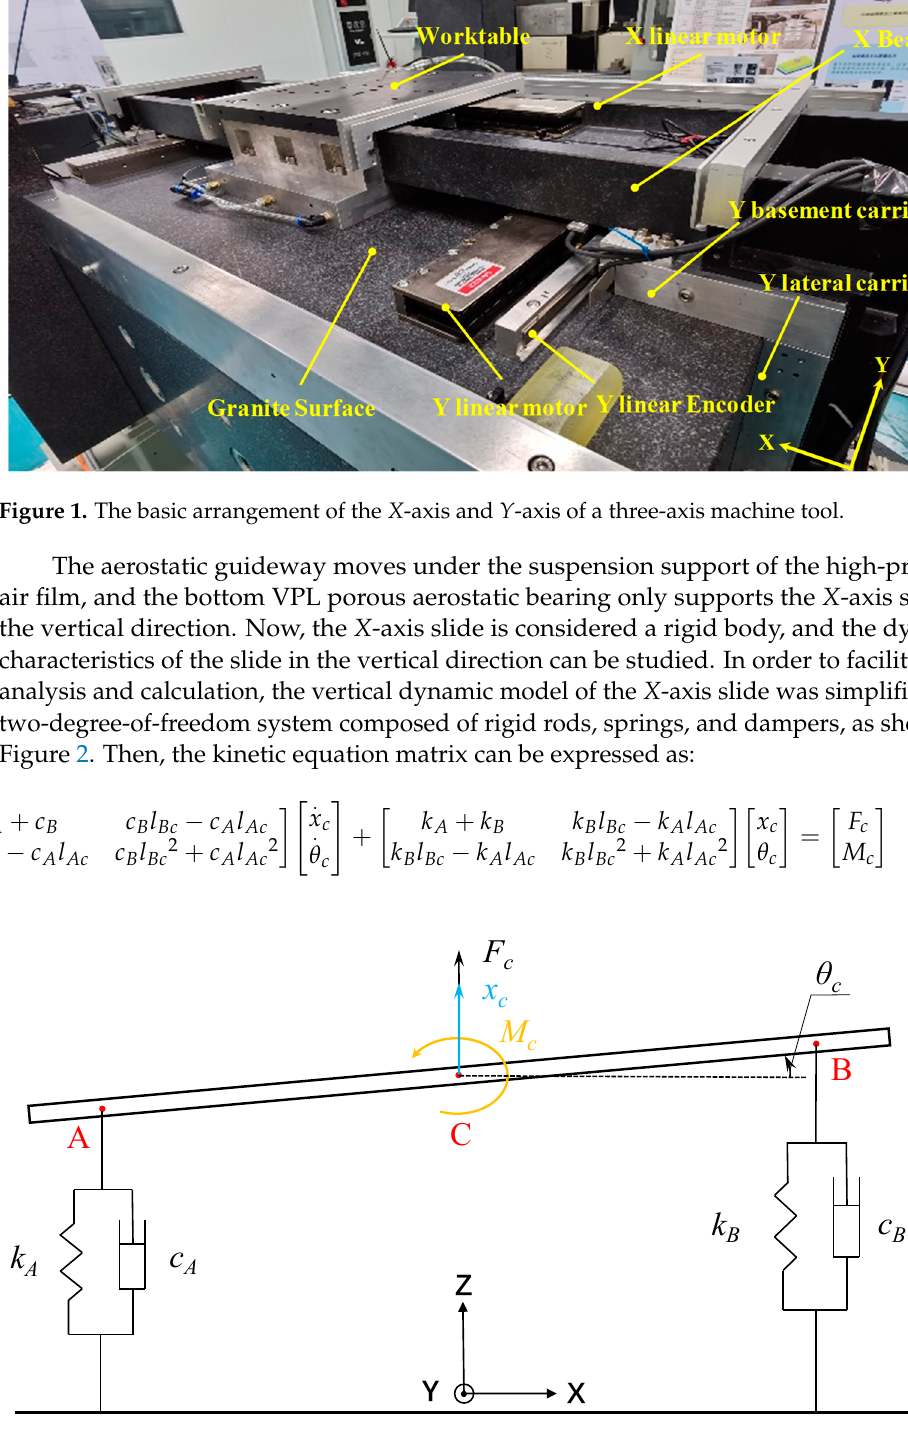
Figure 2. Dynamic model of vertical direction of X -axis slide.